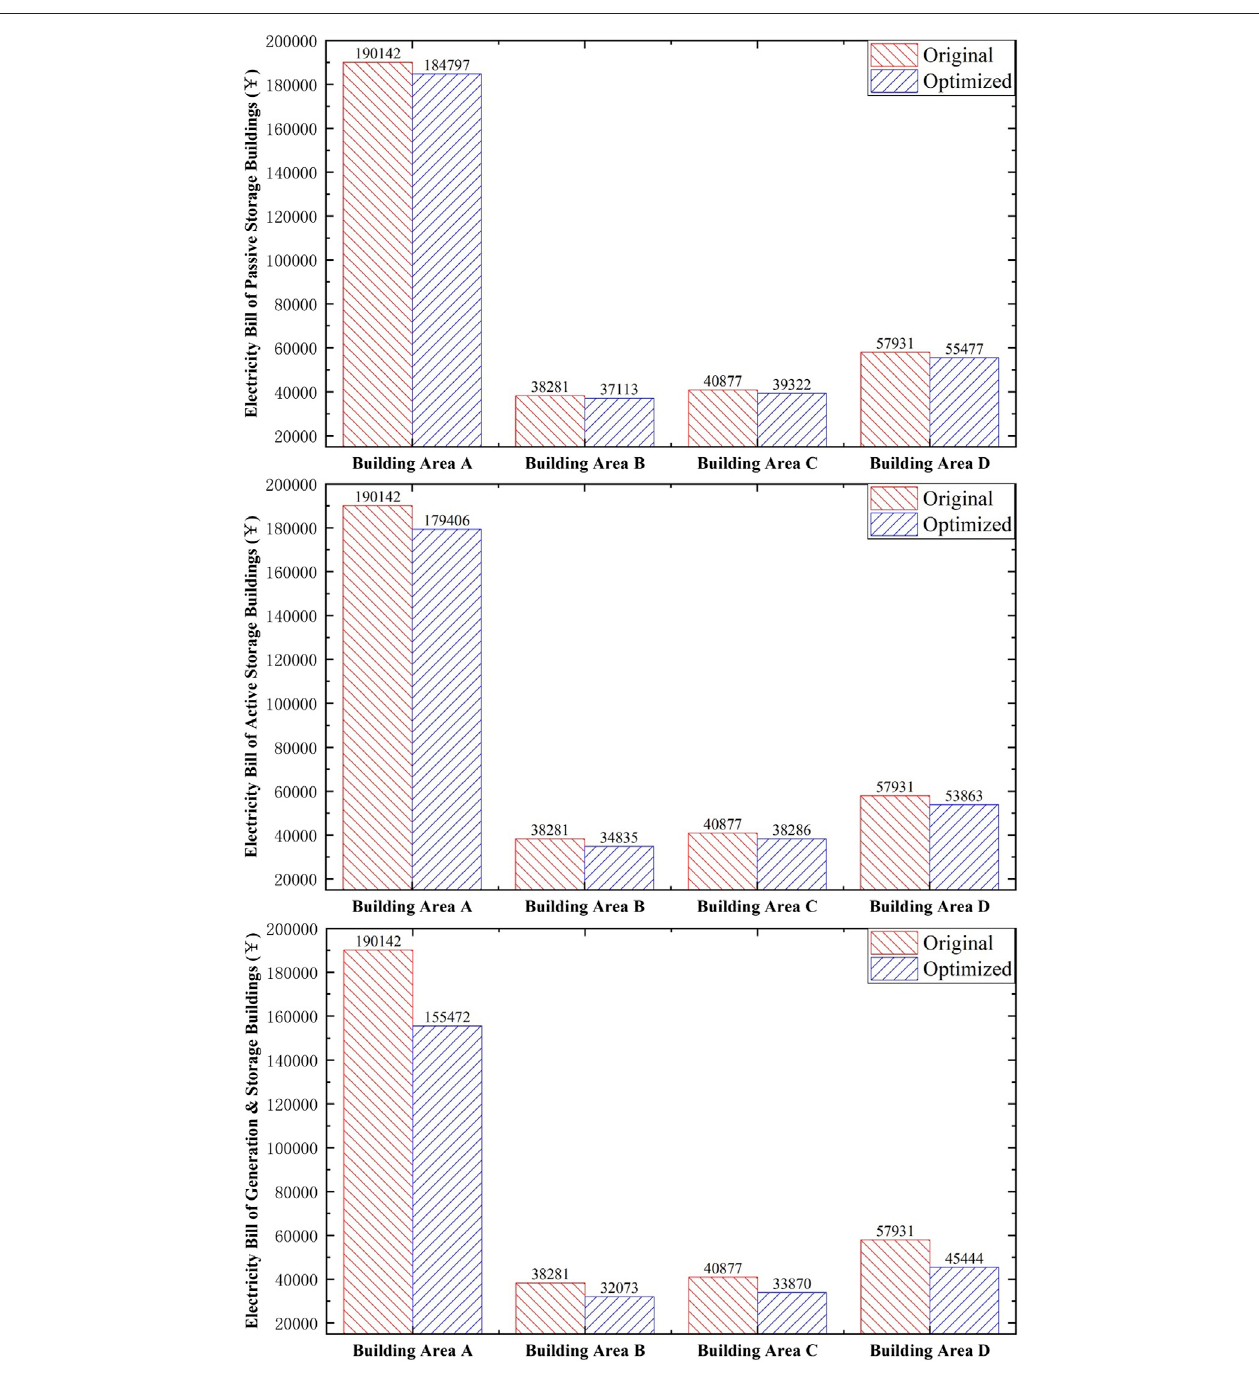
FIGURE 11 | Total electricity bills of buildings with different